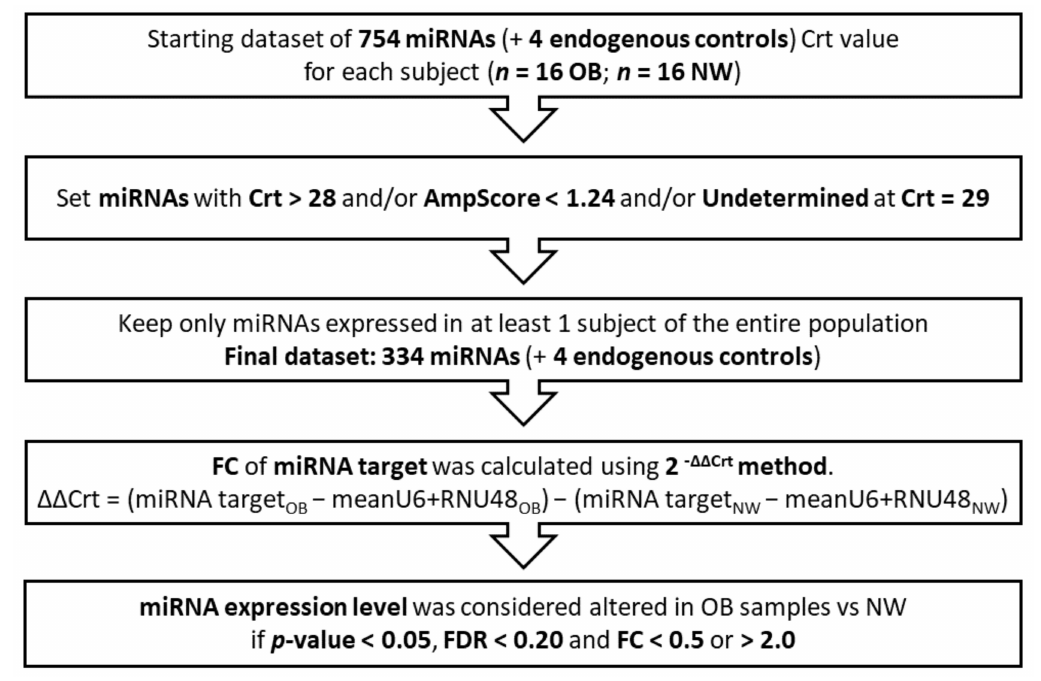
Figure 1. Data processing workflow. OB: Obese, NW: Normal-Weight, Crt: Relative Threshold Cycle, FDR: False Discovery Rate; FC: Fold Change; Bold: highlights the most relevant